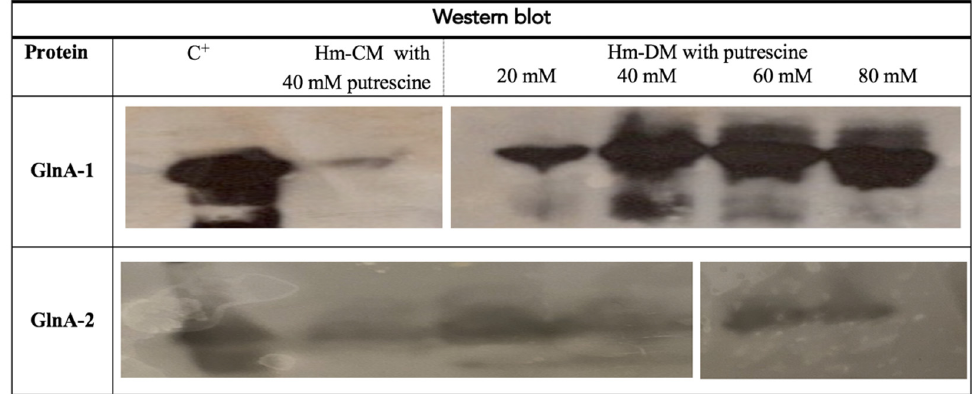
Figure 5. Expression of the GlnA proteins in the presence of different concentrations of putrescine by Western blotting. The positive control (C + ) corresponds to the recombinant protein of GlnA-1 and GlnA-2 proteins. In parallel, the molecular weight of recombinant GlnA-2 protein was calculated using size exclusion chromatography, being 667 kDa (Figure S6). As the molecular weight of GlnA-2 monomer was found to be 55 kDa by SDS-PAGE analysis, it suggests that this protein forms a dodecamer, as does GS. Although the GlnA-2 molecular weight presents a high degree of similarity with that of GS protein, it may not be a GS protein. Similar